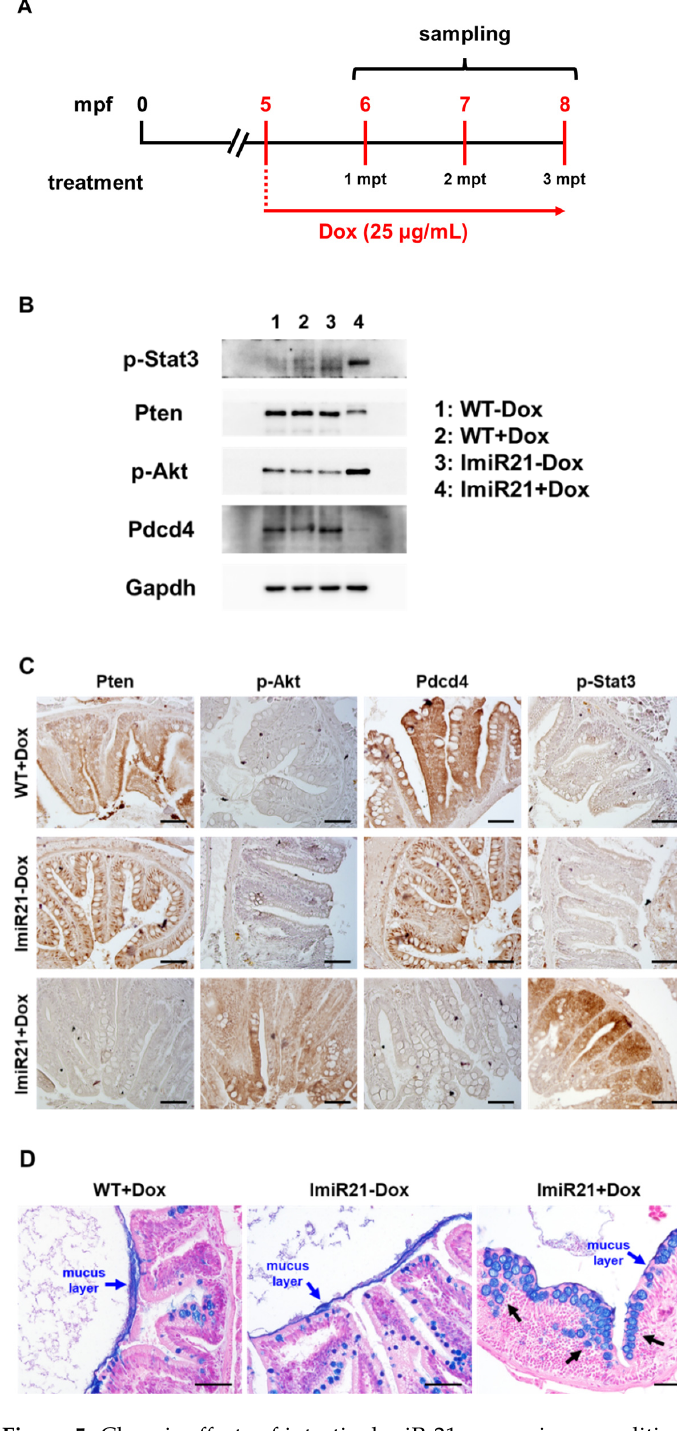
Figure 5. Chronic effects of intestinal miR-21 expression on colitis. ( A ) Schematic diagram of the Dox treatment strategy in adult ImiR-21. ImiR-21 larvae were treated with 25 μ g/mL Dox from 5 to 8 months post-fertilization (mpf). ( B ) Representative Western blots of the intestinal protein of WT ± Dox and ImiR-21 ± Dox at 6 mpf/1 months post-treatment (mpt). ( C ) Expression patterns of Ptenb, p-Akt, Pdcd4, and p-Stat3 in 6 mpf/1 mpt WT + Dox and ImiR-21 ± Dox intestine samples after immunohistochemical staining. Scale bar: 50 μ m. ( D ) Representative images of alcian blue-stained intestines of WT + Dox and ImiR-21 ± Dox at 6 mpf/1 mpt. Goblet cell hyperplasia (black arrow) and reduction of mucus layer (blue arrow) were observed in ImiR-21 + Dox intestine. Scale bar: 50 μ m.